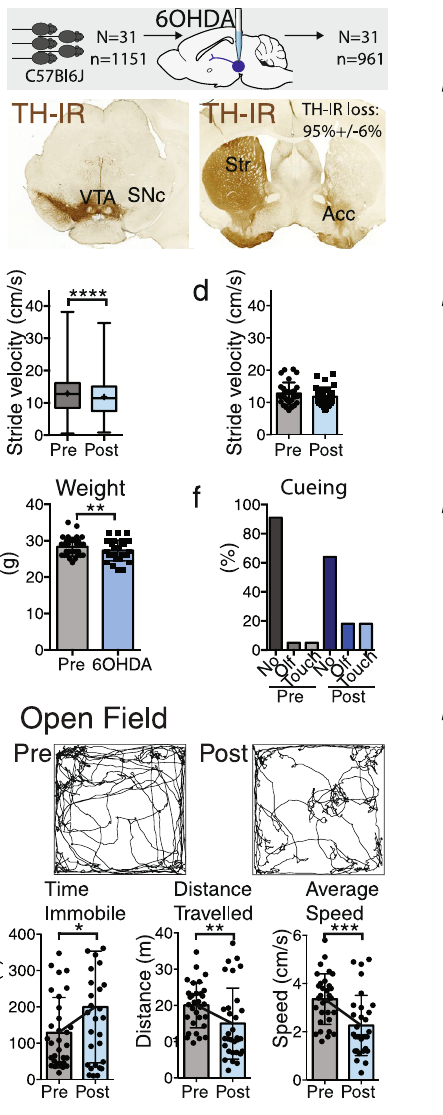
stride-to-stride analysis showed significant changes in all gait parameters except for stance duration (Fig. 3i), whereas averaged data showed a decrease in stride length and swing duration only (Fig. 3j). Mice thrived based upon their increase in weight (Fig. 3e; two tailed paired t-test (t(16) = 3.67, p 0.002) and did not require cueing in order to obtain gait data, i.e. had no difficulties with initiation or continuation of gait (Fig. 3f). Measures of